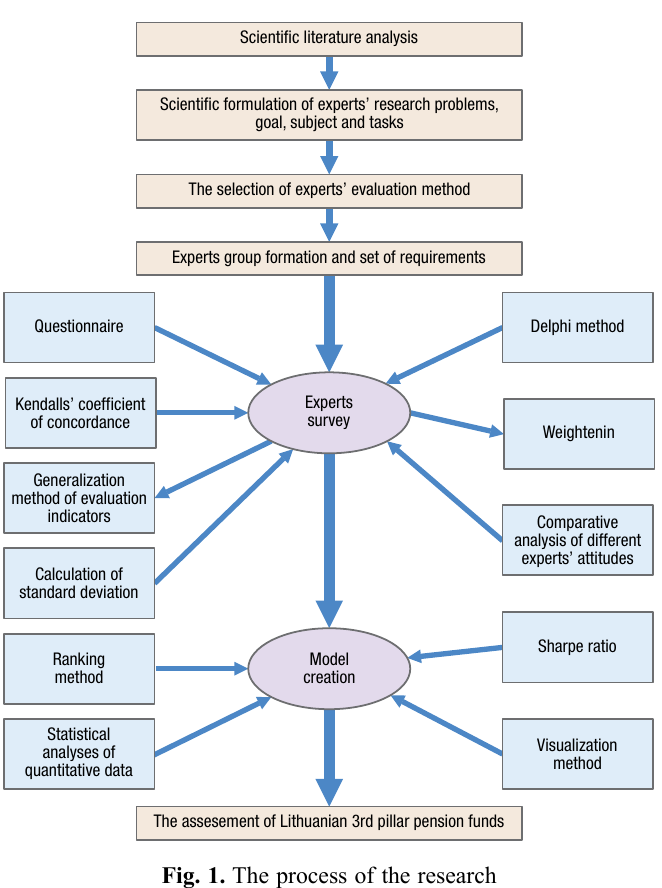
Fig. 1. The process of the research Source : created by